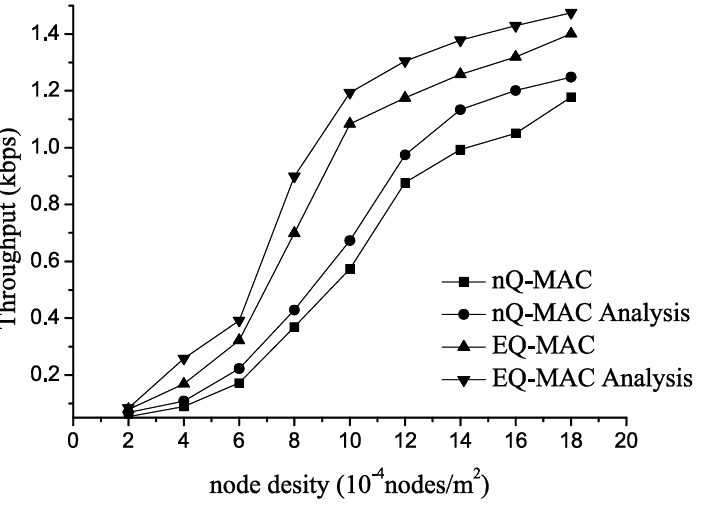
Figure 9. Throughput for H-Pkts vs . Node